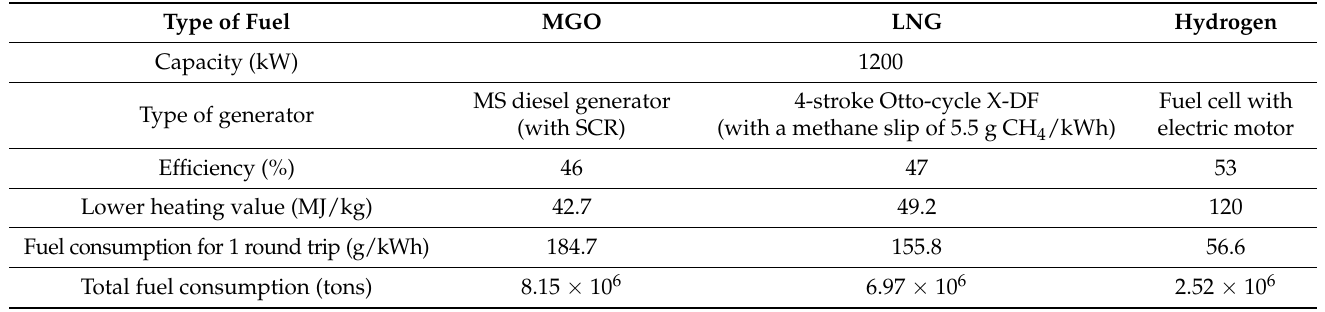
Table 4. Generator and fuel cell specification in the TANK-TO-WAKE